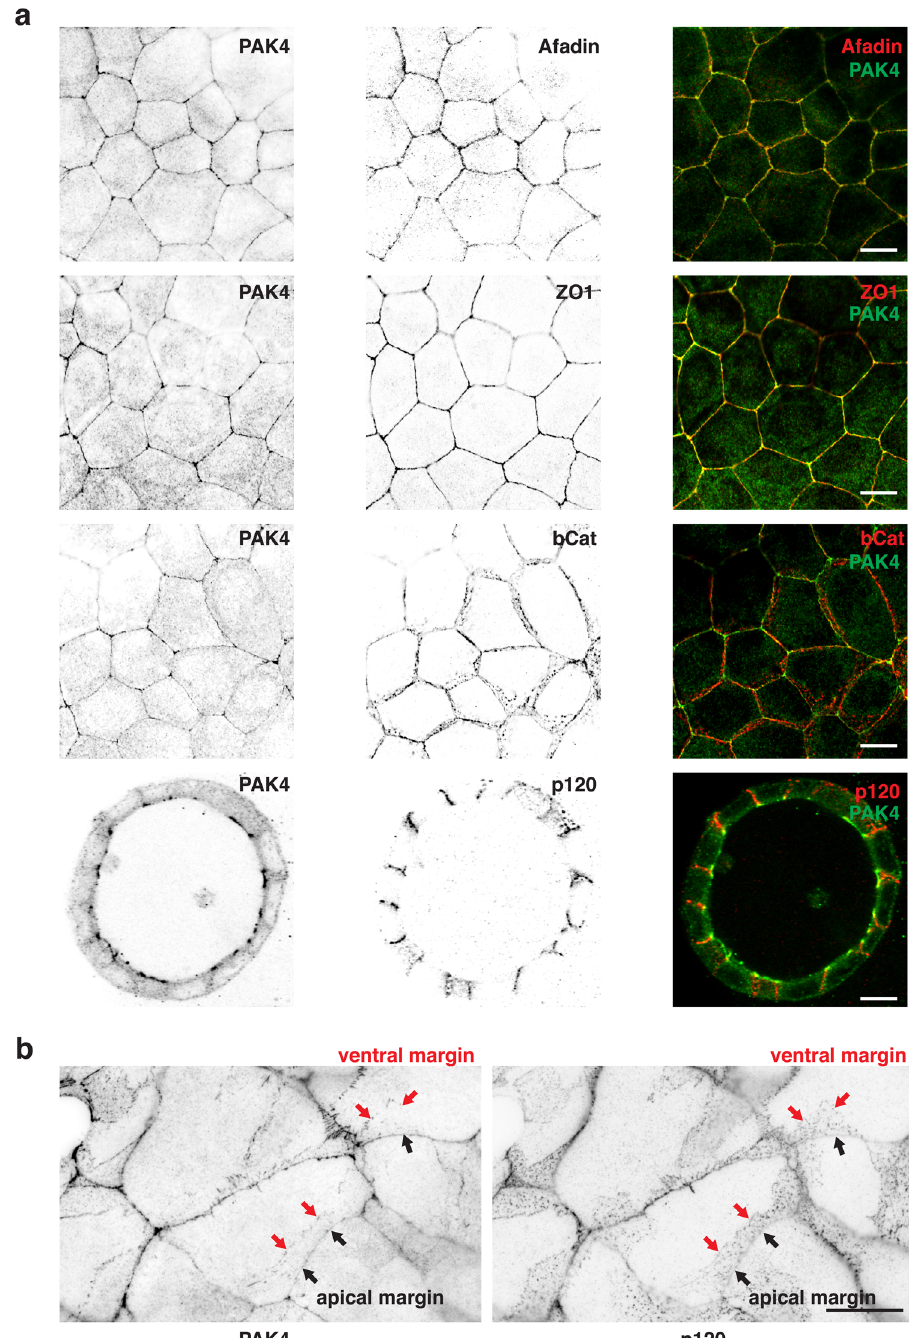
Fig. 3 Disposition of PAK4, Afadin and ZO1 in MDCK cells. a Con fl uent MDCK cells grown on glass coverslips (4 days) were fi xed with methanol and co- stained using rabbit anti-PAK4 and mouse anti-Afadin/anti- β -catenin or anti-ZO1. Images were collected on an Olympus Fluoview confocal microscope with ×100 oil objective. Lower panels show MDCK cell grown in Matrigel to form 3D-cultured acini (8 days) fi xed in methanol and immuno-stained with anti-PAK4, anti-p120ctn (×60 objective). b Sub-con fl uent (2 day) cells were stained using rabbit antibodies speci fi c for PAK4 and mouse antibody speci fi c for p120 (×60 objective). Repeated in three independent experiments. Scale bars: 10 μ